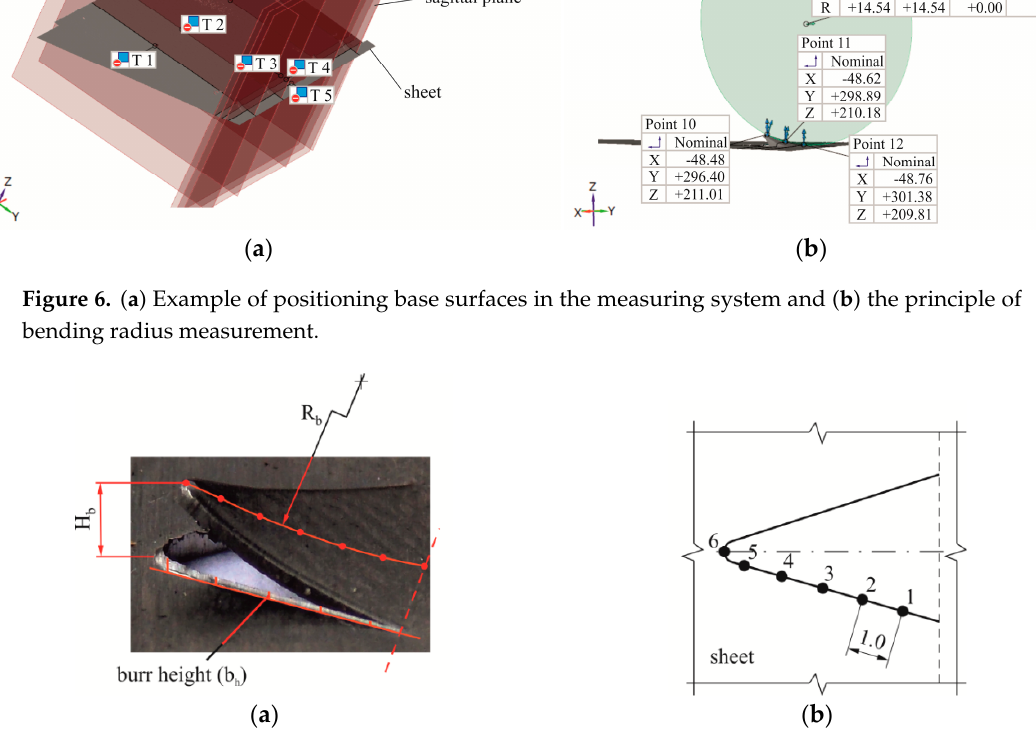
Figure 7. Burr characteristic measurement points ( b h ) and measurements of R b and H b : ( a ) Location of base points to determine the bending radius of the hook and ( b ) read points of the burr values.